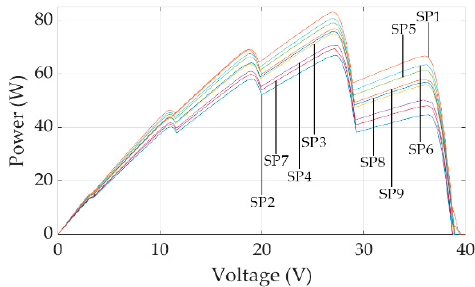
Figure 7. Τ he PV array output power–voltage curves for shading patterns 1–9.